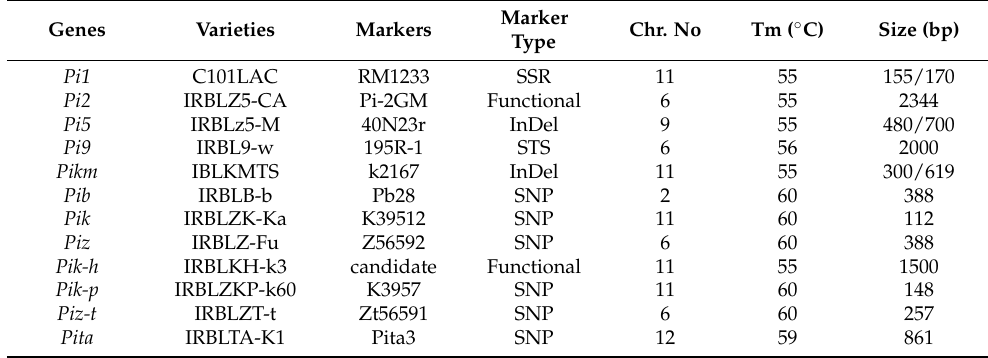
Table 3. List of molecular markers for MAS of rice